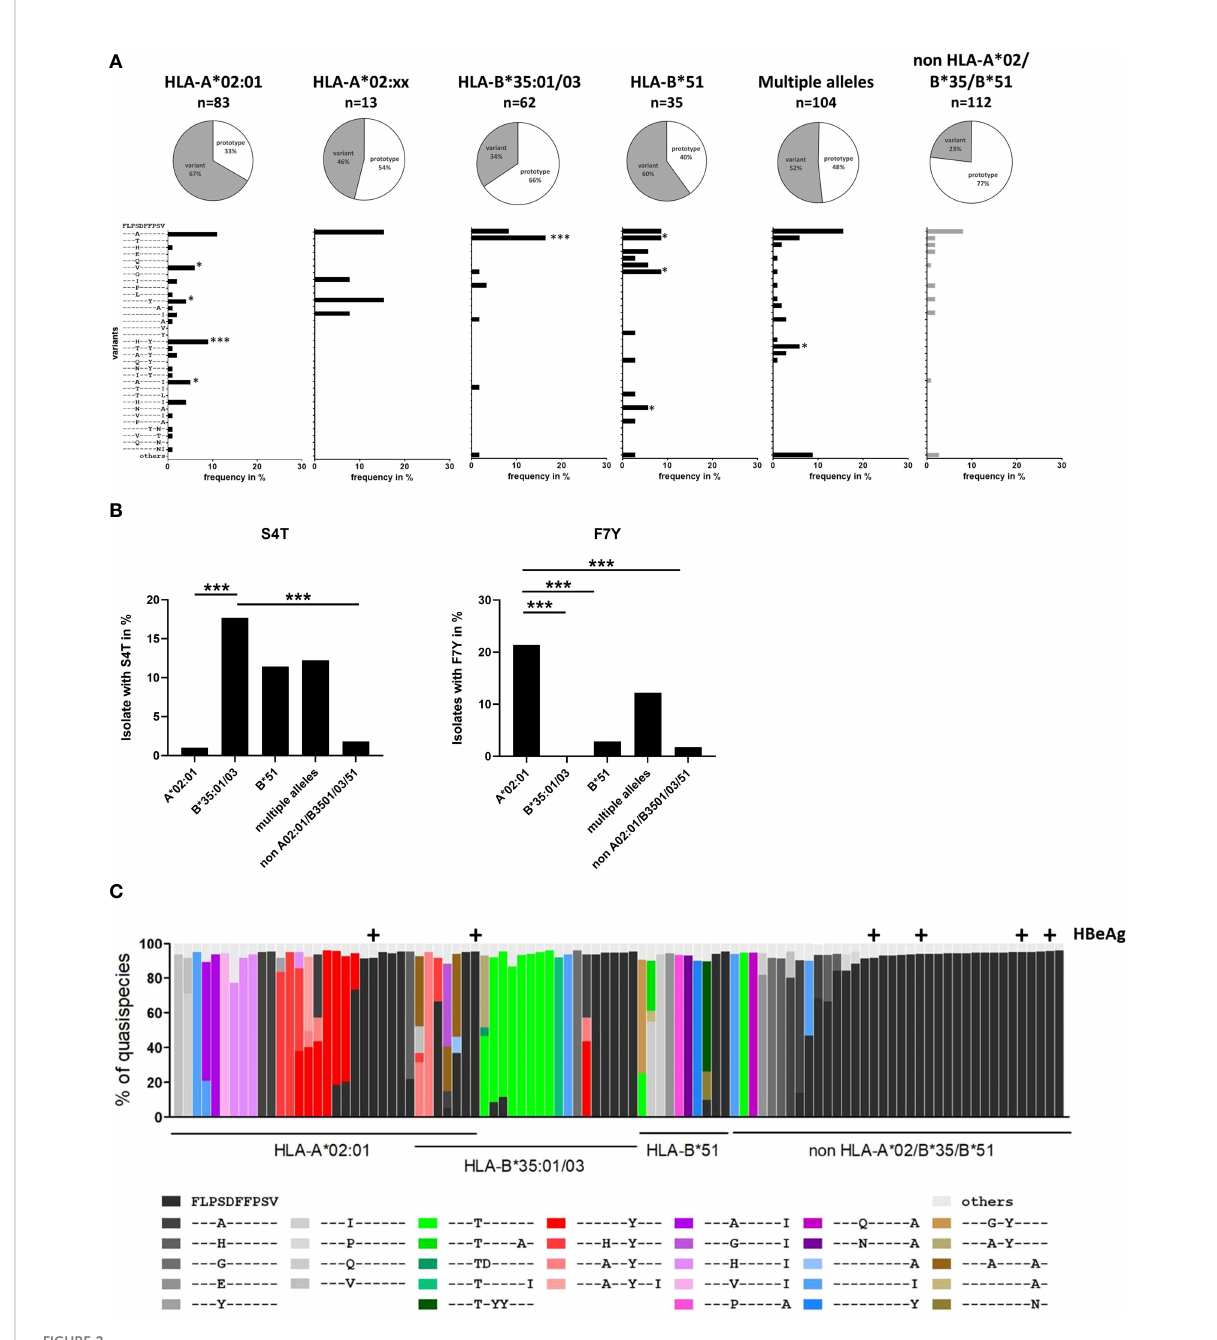
FIGURE 2 Frequency of sequence polymorphisms in the CD8 + T-cell epitope HBV core 18-27 . (A) 717 bp amplicon from the core region was ampli fi ed and Sanger sequenced from 409 patients with known HLA-type and chronic HBV infection (genotype A or D). The pie charts show the frequencies of core 18-27 variants in patients with the depicted HLA-type. The lower panels show the frequencies of individual epitope variants for isolates from patients carrying only HLA-A*02:01, HLA-A*02 subtypes others than A*02:01 (A*02:xx), only HLA-B*35:01/03, only HLA-B*51:01, multiple alleles or none of the relevant alleles. Epitope variants that are signi fi cantly more frequent compared to patients lacking any of the relevant HLA class alleles by Fisher ’ s exact test are indicated (*p < 0.05; ***p < 0.001). (B) Frequency of sequence polymorphisms in the core 18-27 epitope. Cumulative frequencies of sequence polymorphism were calculate regardless of other sequence polymorphism in the core 18-27 epitope for S4T (left) and F7Y (Right). (C) Analysis of HLA-associated frequencies of individual variants in the core 18-27 region within the quasispecies. Amplicons of 96-randomly chosen patients from (A) were submitted to high-throughput sequencing with a mean coverage of 15-20.000x. Reads were aligned to the patient-speci fi c reference sequence generated by Sanger sequencing. Each bar represents the core 18-27 region of one patient with the individual epitope variants being color coded as indicated. Only variants with frequencies >5% of the quasispecies are shown. Samples from HBeAg-positive patients are marked above the column with